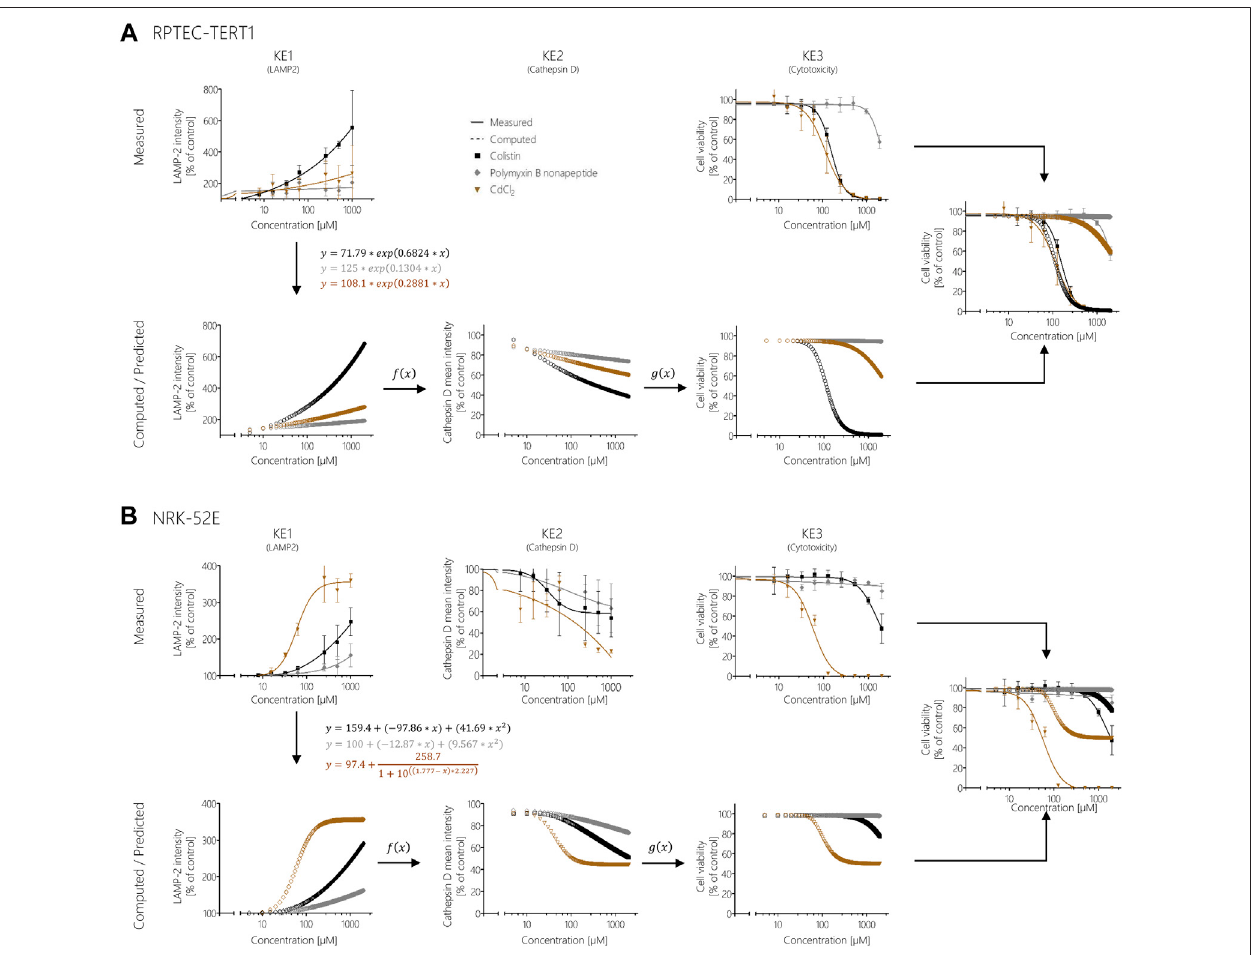
FIGURE 8 | Prediction of colistin, polymyxin B nonapeptide, and CdCl 2 cytotoxicity using response-response relationships based on polymyxin B data in RPTEC/ TERT1 (A) and NRK-52E (B) .Experimentally determined KE1data(disturbance oflysosomal function) obtained after treatment ofcells withcolistin (black), PBNP (grey), and CdCl 2 (brown) represented by solidlineswere used tocalculateadditional datapoints (dotted lines)from theobtained mathematical equations for KE1 (disturbance of lysosomal function). Computed KE1 data were then used to predict KE2 (disruption of lysosomes) (dotted lines) using qKER1 ( f(x) ) obtained from polymyxin B data.Asa fi nalstep,thepredictedKE2datawereutilizedusingqKER2( g(x) )frompolymyxinBdatatopredictKE3(cytotoxicity)(dottedlines).Forbettercomparison,the dose-response curves of the experimentally determined cytotoxicity (solid lines) and the predicted cytotoxicity (dotted lines) were merged into a single graph.